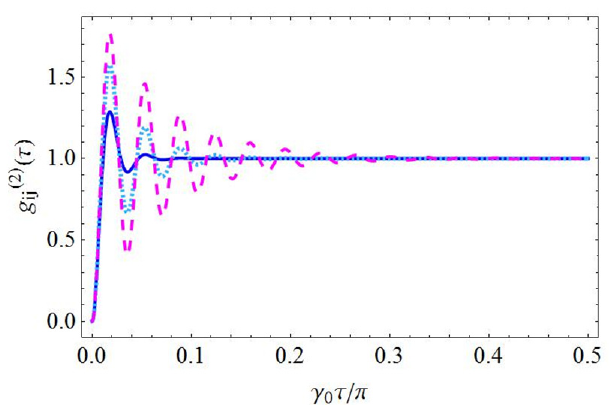
decay process, the second-order correlation functions evolve over time in an oscillatory manner. More explicitly, they exhibit a symmetric oscillatory pattern with mean value equal √ to unity and period equal to 2 π / Ω , independent of the distance that separates the QE from the gold nanosphere (blue solid curve, turquoise dotted curve and magenta dashed curve respectively correspond to d = 10, 27 and 50 nm). As the QE is brought closer to the gold nanosphere, the spontaneous emission rate Γ ⊥ is substantially increased ( (cid:39) 3.11 γ 0 , for d = 50 nm, (cid:39) 6.60 γ 0 for d = 27 nm and (cid:39) 14.83 γ 0 , for d = 10 nm) and, due to this effect, the damping coefficient increases monotonically. In Figure 7, it becomes evident that the time which is required in order to pass from the antibunching to the bunching region (crossing time) does not depend on the interparticle distance. The zero value at τ = 0 expresses the zero probability of identifying two fluorescent photons simultaneously, due to the depletion of the system. If we decrease the intensity of the incident field at a high extent (practically when takes values below Ω < 5 γ 0 , when d = 50 nm), the damping rate presents an important suppression. In this specific case, which will be investigated in Figure 9, the second-order correlation functions always remain in the antibunching region and, thus, the successive emission of another fluorescent photon is hindered.